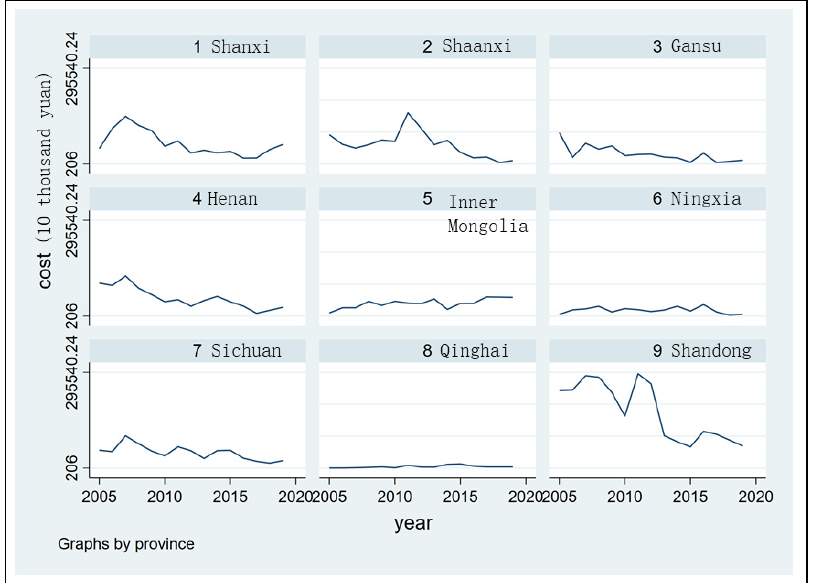
Figure 3. The time trend graph of investment in industrial sewage treatment in 9 provinces along the YRB.